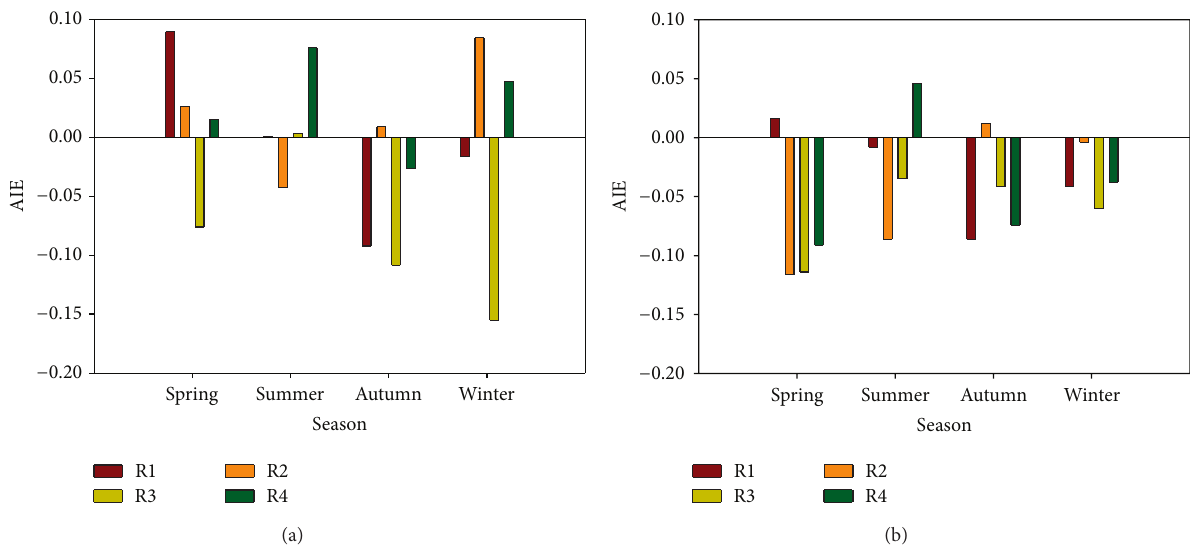
Figure 5: Seasonal climatological mean of aerosol indirect effect of (a) ice and (b) water particle in R1 (red), R2 (orange), R3 (yellow), and R4 (green).